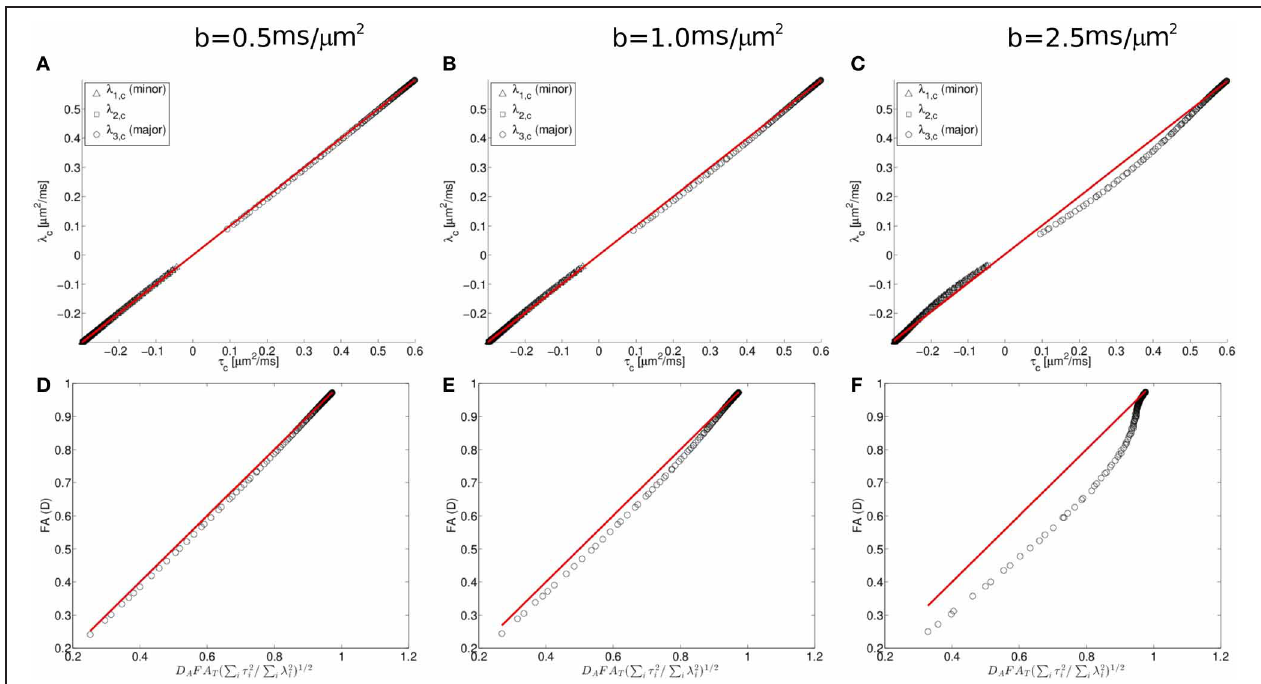
FIGURE 6 | Diffusion and scatter matrix centralized eigenvalues ( λ and τ , respectively) plotted for simulated data (A–C; see text for details) and fractional anisotropy computed from the centralized eigenvalues for the diffusion tensor and orientation distribution matrices (D–F). These data